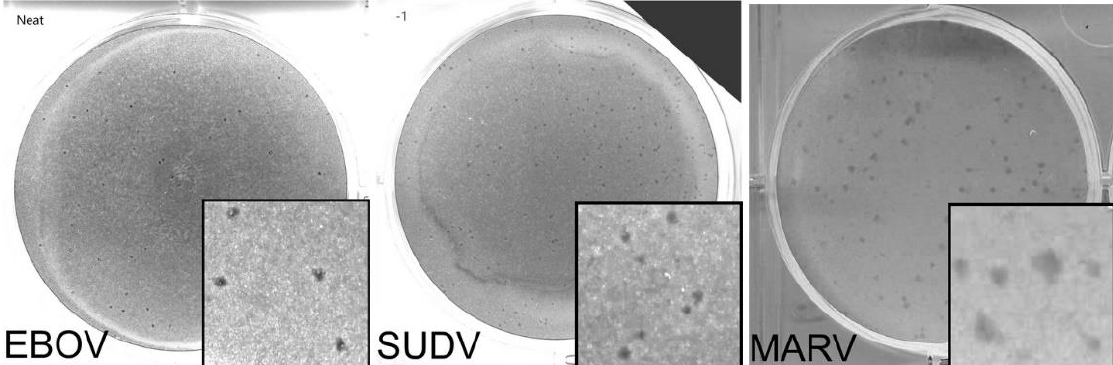
Figure 2. Representative images of CVMO plaque assay for EBOV, MARV, and SUDV. Here, a single well from a 6 well plate is used as a representative image for EBOV (left), SUDV (middle), and MARV (right) with insets (3.5 mm width) showing a magnified area. Images have been changed to greyscale to increase plaque visibility. Plaques may be faint, as seen in the EBOV image, or form a dark CVMO aggregate, as seen in MARV. These are counted to give the final sample titer. Dilutions used here: EBOV 1:1, SUDV 10 −1 , MARV 10 −1 .